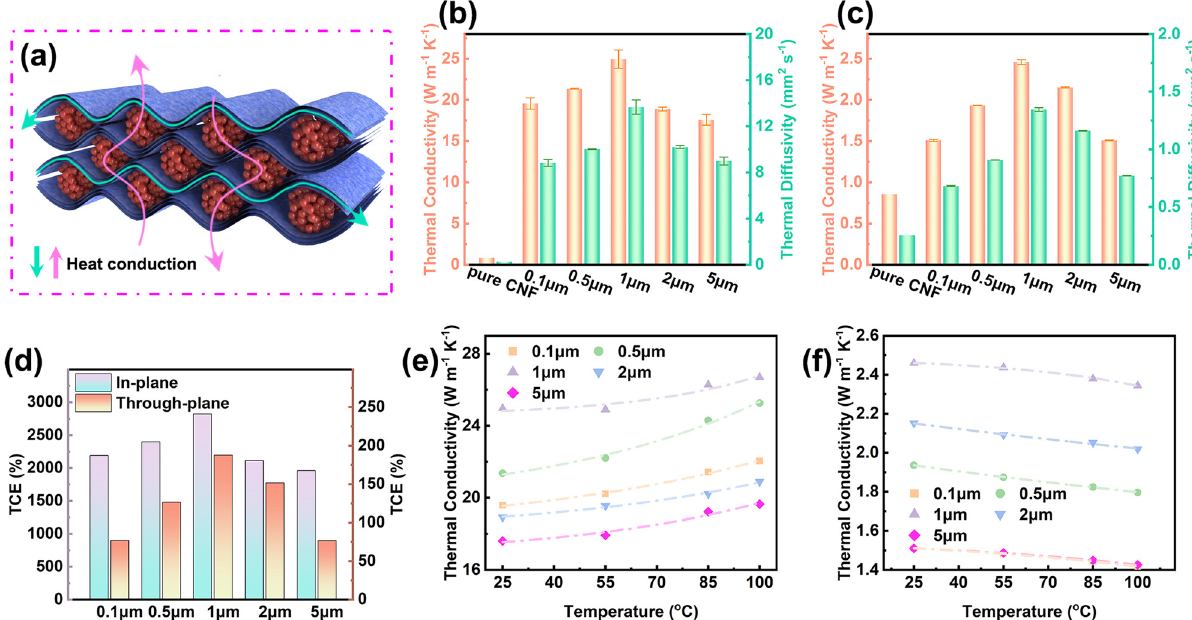
Figure 4: ( a ) Mechanism diagram of heating conduction of composite fi lms. Thermal conductivity of the pure CNF fi lm and the MXene/Cu/ CNF fi lms with di ff erent copper powder diameters with 0.1, 0.5, 1, 2, and 5 μ m in the ( b ) in - plane and ( c ) through - plane directions. ( d ) Thermal conductivity enhancement ( TCE ) and thermal conductivity in the ( e ) in - plane and ( f ) through - plane directions as a function of the temperature of the MXene/Cu/CNF fi lms with di ff erent copper powder diameters with 0.1, 0.5, 1, 2, and 5 μ m,